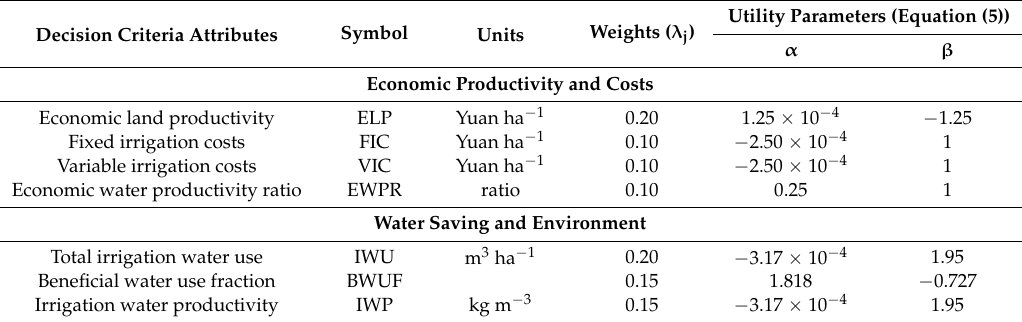
Table 8. Criteria attributes, utility functions, and